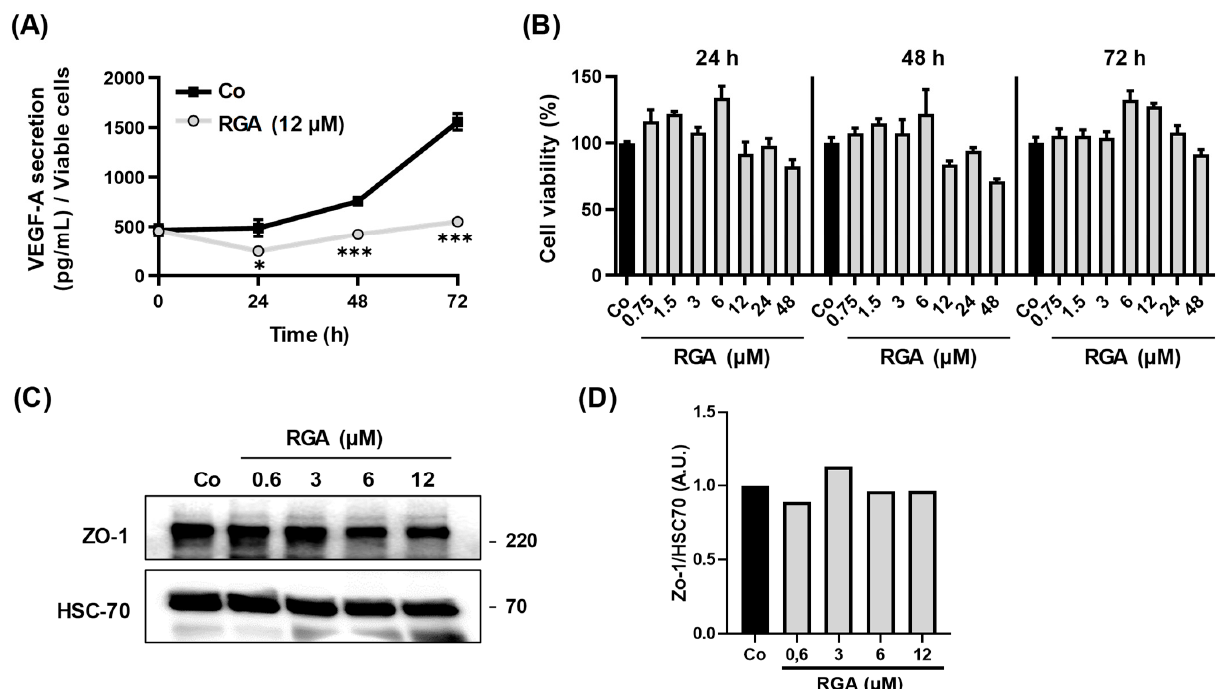
Figure 1. RGA formulation disrupts VEGF-A secretion over time in human ARPE-19 retina cells. ( A ) ARPE-19 retina cells were treated for 24, 48 and 72 h without serum with vehicle as control (Co) or with RGA (12 µ M). VEGF-A secretion was measured in cell medium by ELISA assay. The data are mean ± S.D. of four independent experiments with n = 10. p values were determined by one-way ANOVA followed by Tukey’s multiple comparison test of treatments vs. control. * p < 0.05, and *** p < 0.001. ( B ) ARPE-19 cells were treated with 12 µ M of RGA at 37 ◦ C for 24, 48 and 72 h. The percentage of cell viability was determined by crystal violet assay. Results are expressed as a percentage of control (mean ± SD of three independent experiments with n = 10). ( C ) Immunoblot analysis of ZO-1 in RGA treated ARPE-19 cells with increasing concentration (0.6, 3, 6, 12 µ M) or with vehicle (Co) for 24 h. HSC-70 was used as a loading control. ( D ) Densitometry quantification of western blotting. Data are expressed as the mean fold induction compared to control